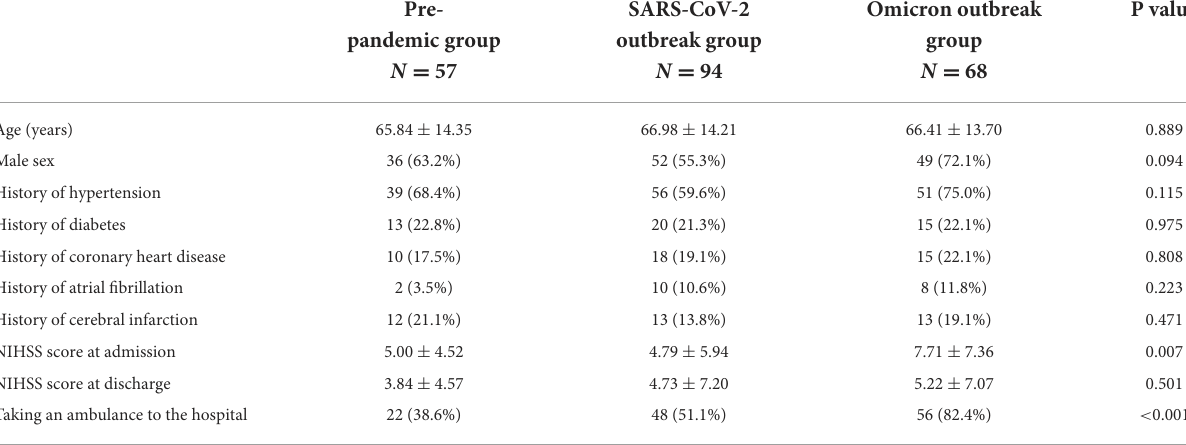
TABLE 1 Baseline information of three patients groups undergoing intravenous